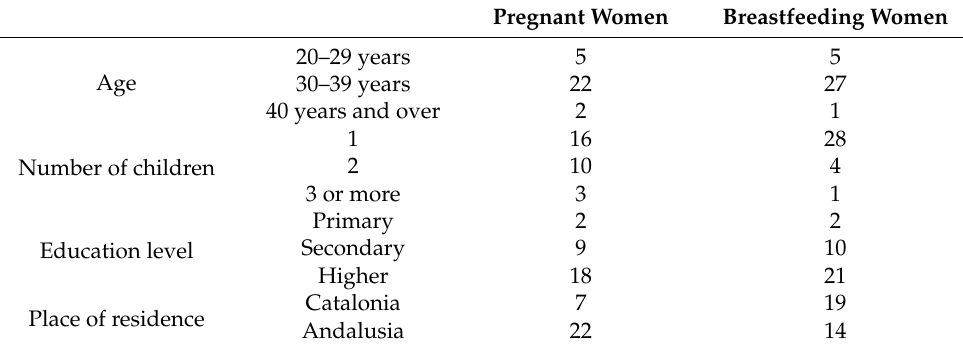
Table 2. Second phase. Sociodemographic characteristics of the